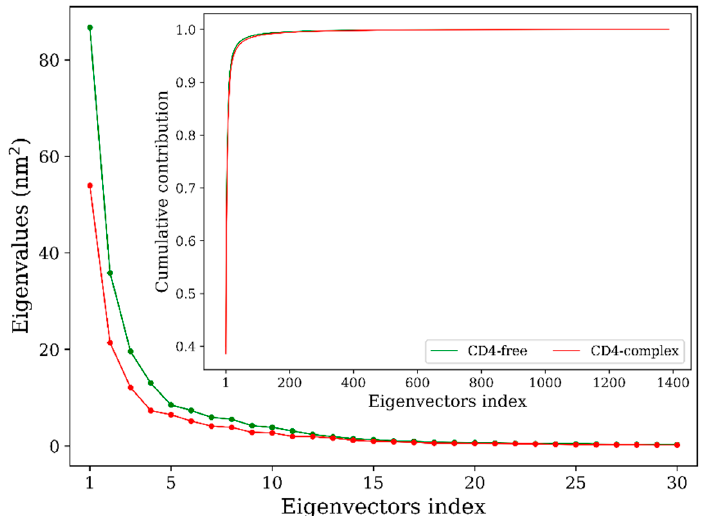
Figure 4. Eigenvalues as a function of eigenvector index obtained from principal component analyses of the joined equilibrium trajectories of the CD4-free (green line) and CD4-complexed (red line) gp120s. Main plot shows the eigenvalues of only the first 30 eigenvectors; inset plot is the cumulative contribution of all eigenvectors to the total mean square fluctuations.